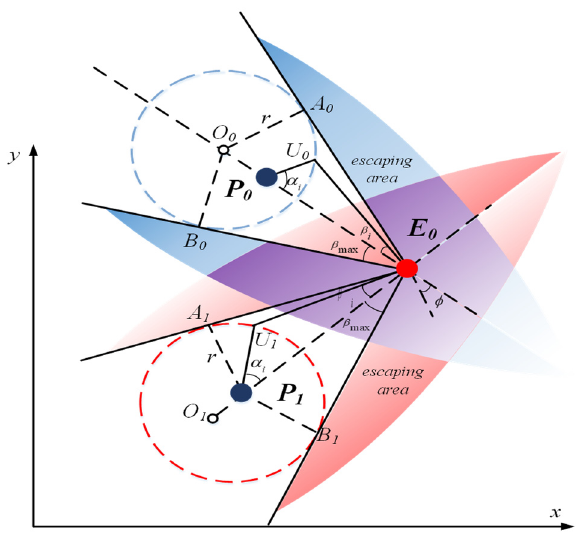
Figure 7. A game between two pursuers and one evader based on Apollonius circles.